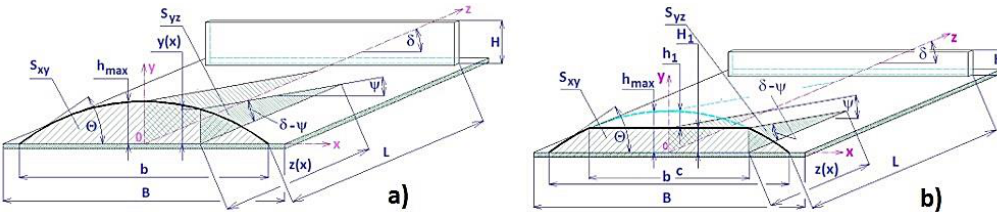
Figure 5. Transverse and longitudinal cross-section through a batch of transported material ( a ) H ≥ h max , ( b ) H 1 ≤ h max .